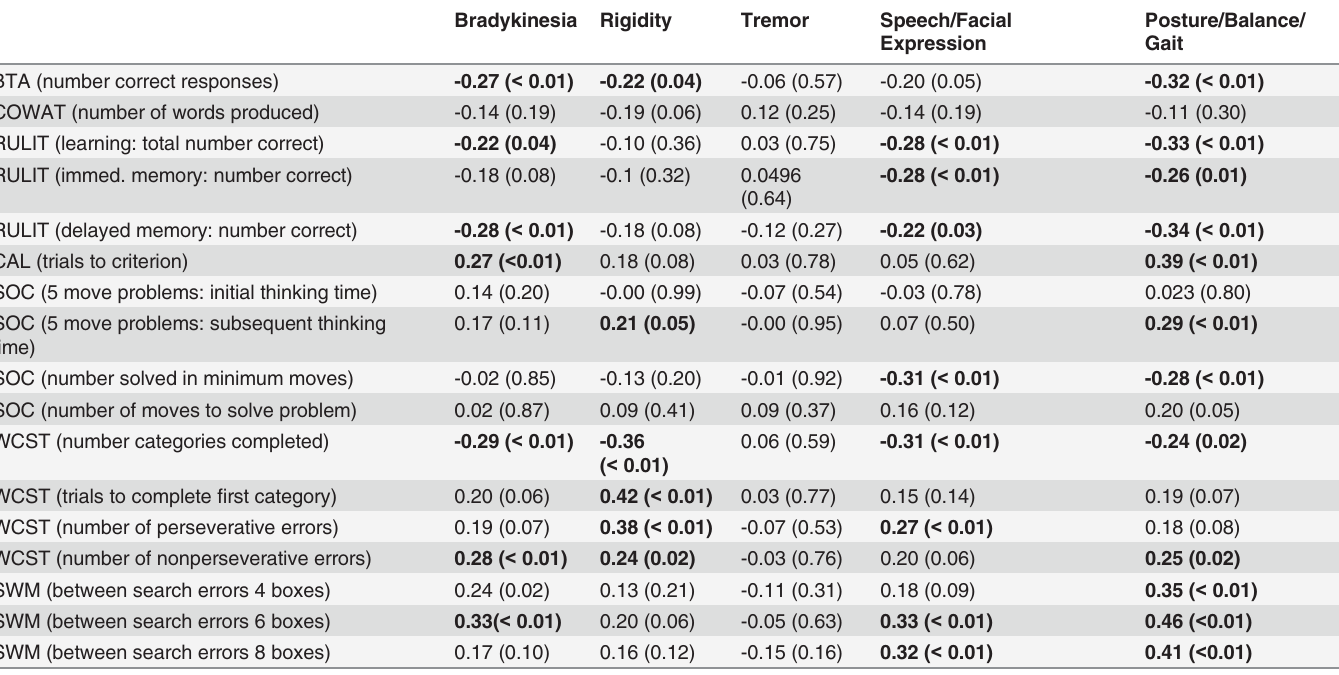
Table 4. Correlations Between Neuropsychological Performance and Off UPDRS Motor Scores [r (p value)].